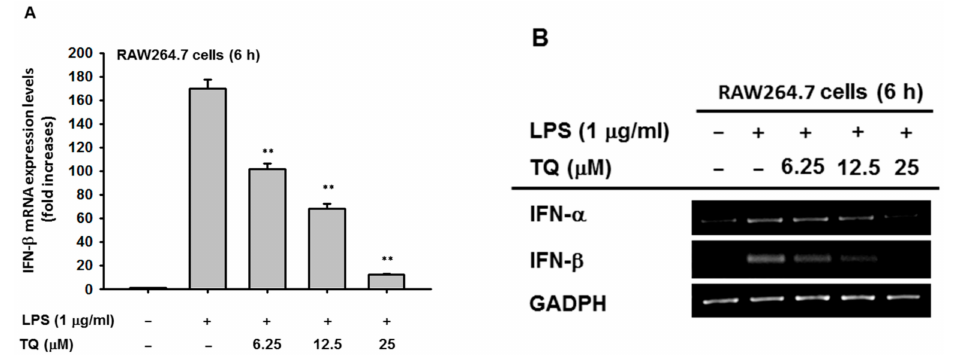
Figure 2. TQ downregulates mRNA expression of type I interferon (IFN) . ( A ) RAW264.7 cells (1 × 10 6 cells/mL) were pretreated with TQ at the indicated doses for 30 min, followed by incubation with lipopolysaccharide (LPS) (1 µ g/mL) for 6 h. mRNA expression levels of IFN- β and GAPDH (as a reference) were determined by real-time PCR; ( B ) mRNA expression levels of IFN- α , IFN- β , and GAPDH (loading control) were determined by semiquantitative reverse transcriptase PCR. All data are expressed as the mean ± SD. ** p < 0.01 compared to the control group (LPS